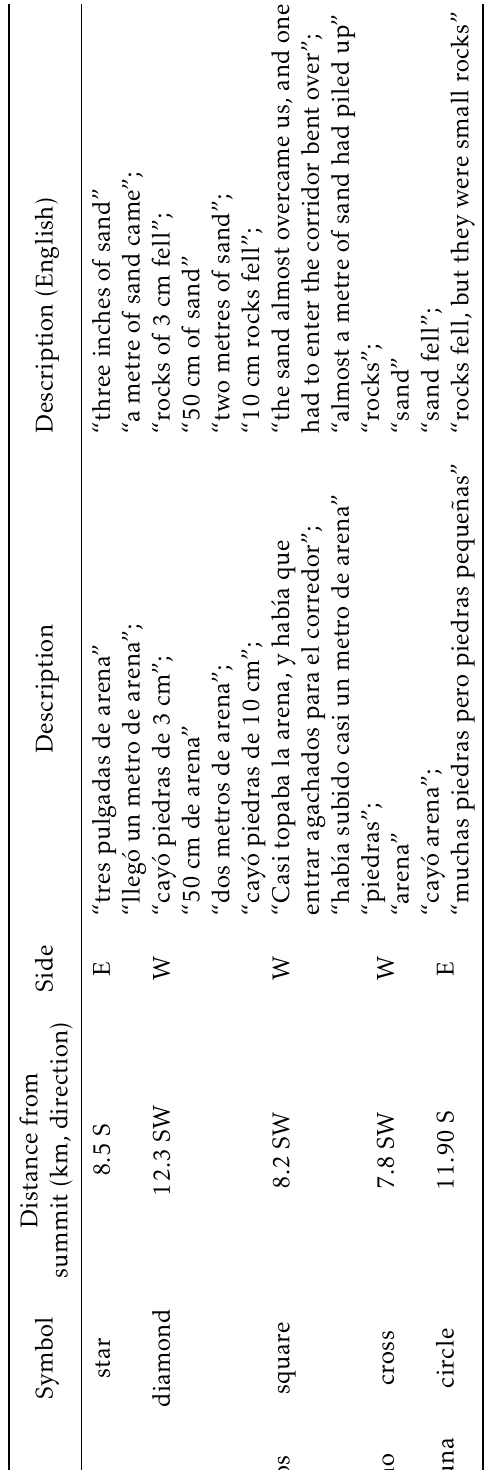
Table 3 – Community descriptions of tephra fall associ- ated with the October 1974 eruptive episode.